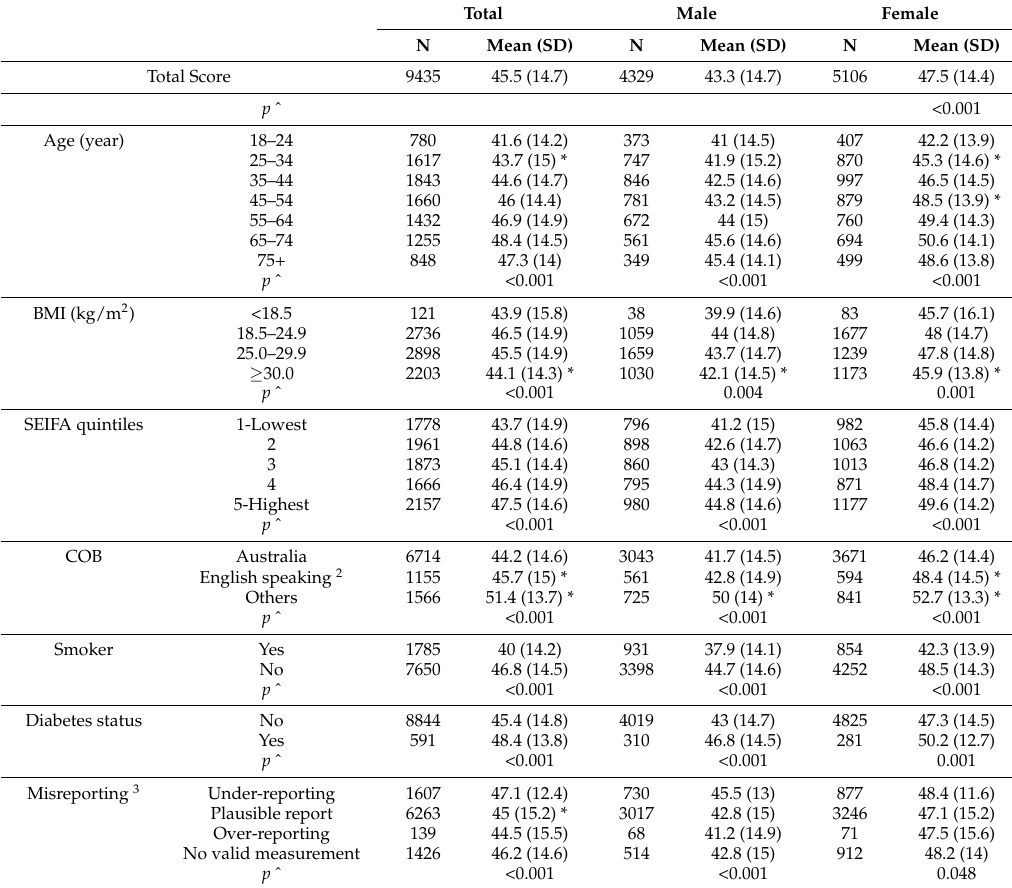
Table 1. Healthy Eating Index for Australian Adults (HEIFA-2013) mean (SD) score 1 by socio-demographic